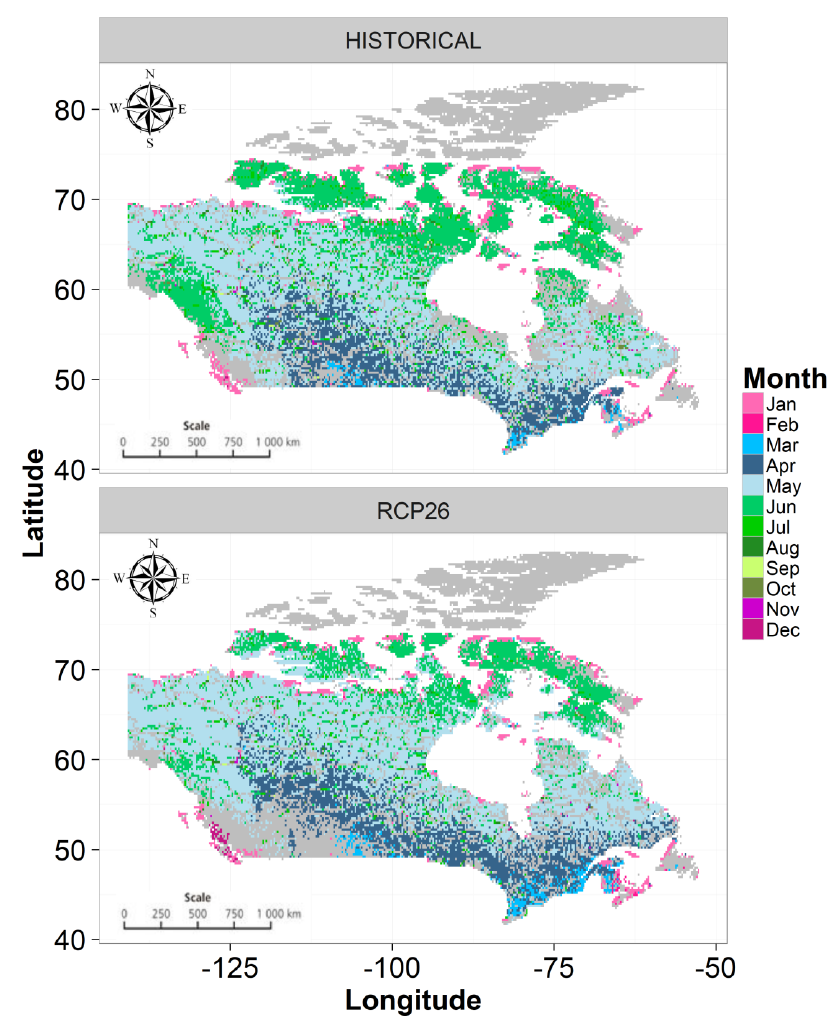
Figure 7. Monthly distribution of extreme flows obtained from aggregated runoff results obtained for historical and future timelines. Future projections are presented for RCP 2.6.